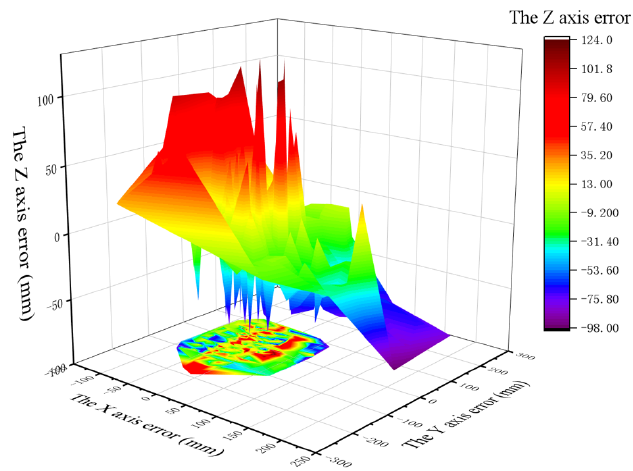
Figure 15. 3D ( X , Y , Z ) accuracy of normal data sets based on C-T-CNN-SVM algorithm.